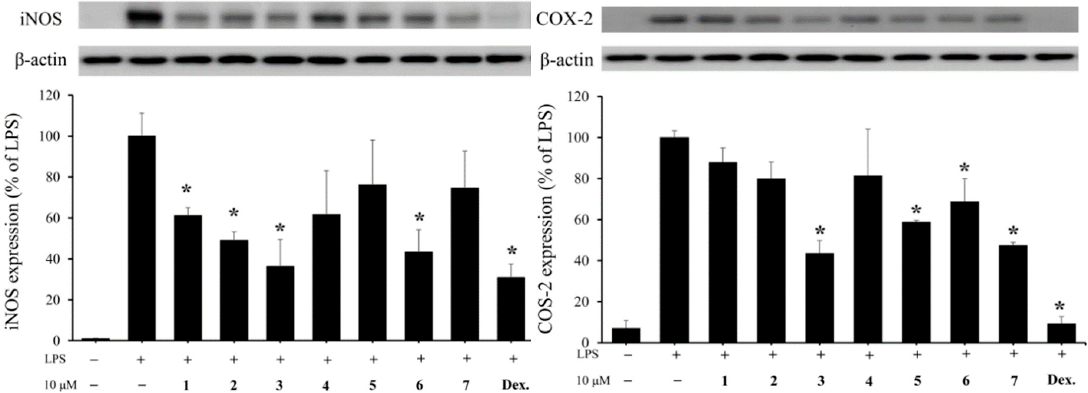
Figure 4. Effects of compounds 1 – 7 on the expression of pro-inflammatory iNOS and COX-2 proteins in lipopolysaccharide (LPS)-treated murine RAW264.7 macrophage cells. West blotting showed that briaranes 2 , 3 , and 6 inhibited LPS-induced iNOS expressions and briaranes 3 and 7 downregulated the expression of COX-2. Data were normalized to the cells treated with LPS only, and cells treated with dexamethasone (10 μ M) were used as a positive control (which reduced the iNOS and COX-2 levels to 30.83 and 9.32%, respectively). Data are expressed as the mean ± SEM ( n = 4). * Significantly different from cells treated with LPS ( p < 0.05).